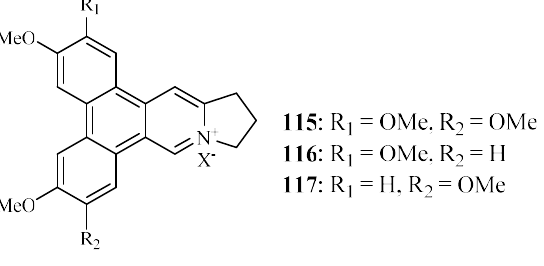
Figure 25. Compounds from a Moraceae plant.